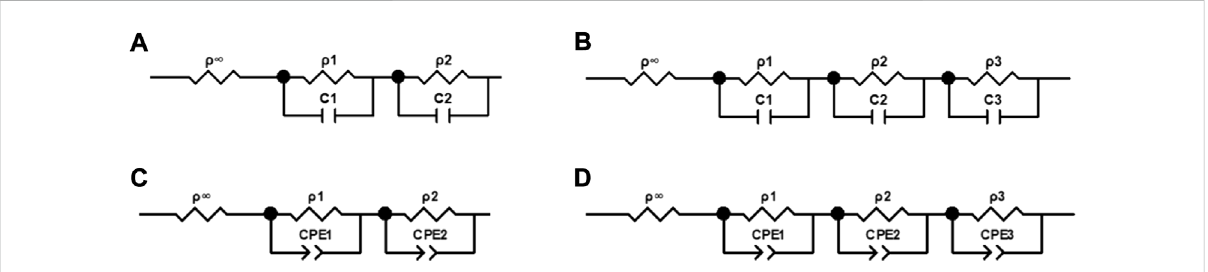
FIGURE 2 Equivalent circuits of complex electrical resistivity of blood. (A) Circuit containing two parallel resistors and capacitors. (B) Circuit containing three parallel resistors and capacitors. (C) Circuit containing two parallel resistors and constant phase elements. (D) Circuit containing three parallel resistors and constant phase elements.